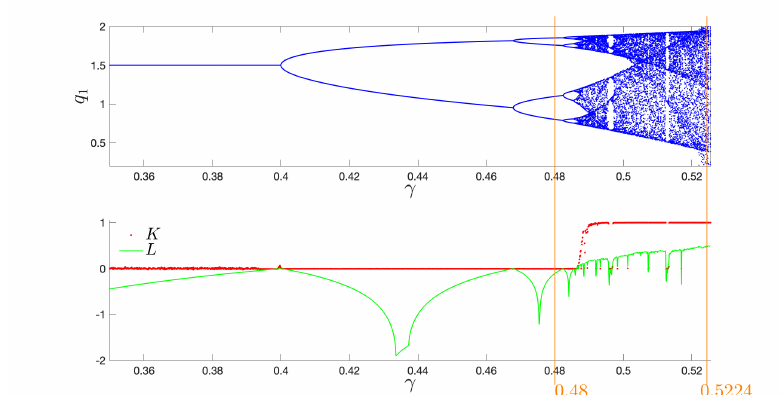
Figure 1. Heterogeneous Cournot oligopoly model (HCOM) Equation (8) system’s ( upper ) BD γ and ( lower ) K , L for q 1